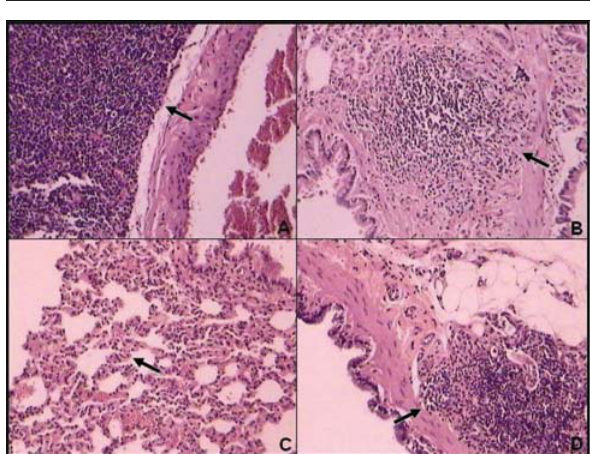
FIGURE 1 - Microscopy of the pulmonary sections of the Control Group. A) 08 weeks. Diffuse chronic inflammatory process is noticed, the arrow shows alveolar acinus with the presence of protean exsudate. B) 10 weeks. Diffuse chronic inflammatory process. The arrow indicates an area of pulmonary emphysema. C) 12 weeks. Diffuse chronic inflammatory process. The arrow indicates thickness of the alveolar wall after the inflammation. D) 14 weeks. Diffuse chronic inflammatory process, with emphysema areas and thickness of the alveolar walls. (HE, 100X)